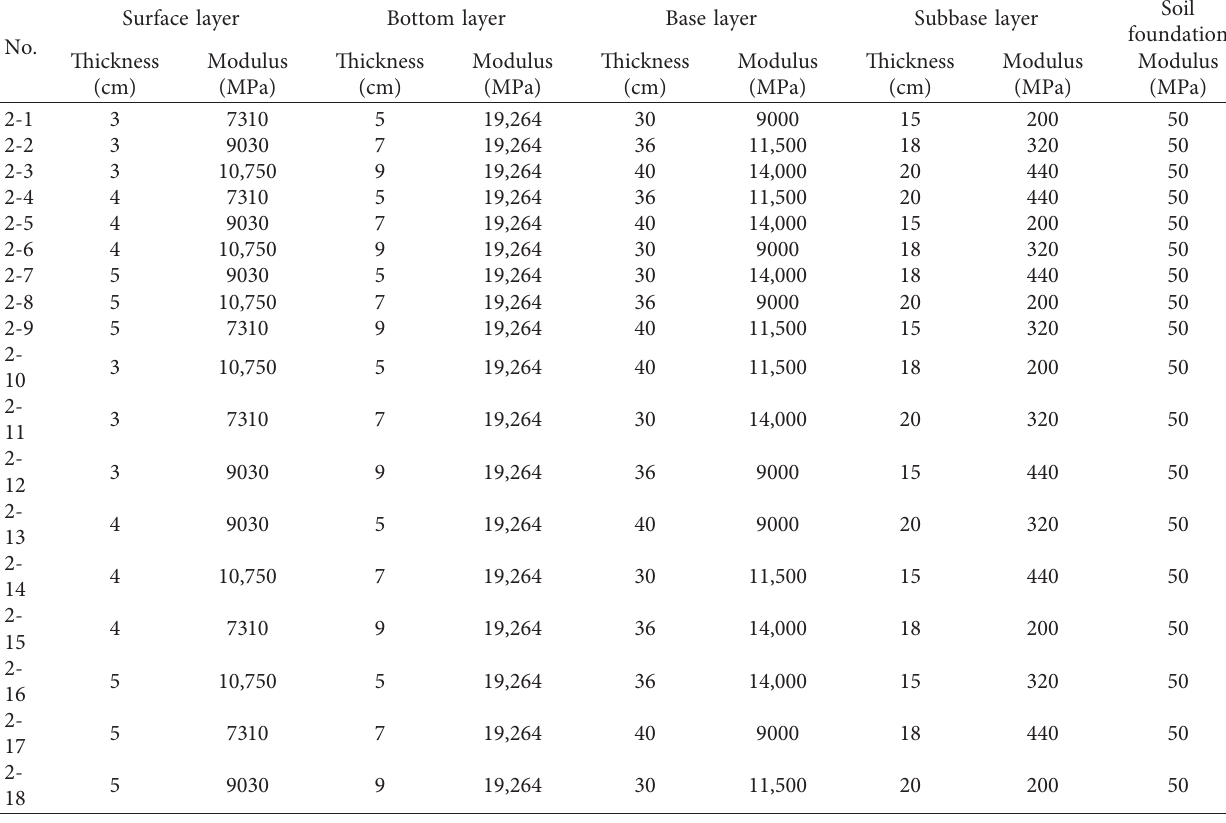
Table 4: Working condition II the orthogonal test